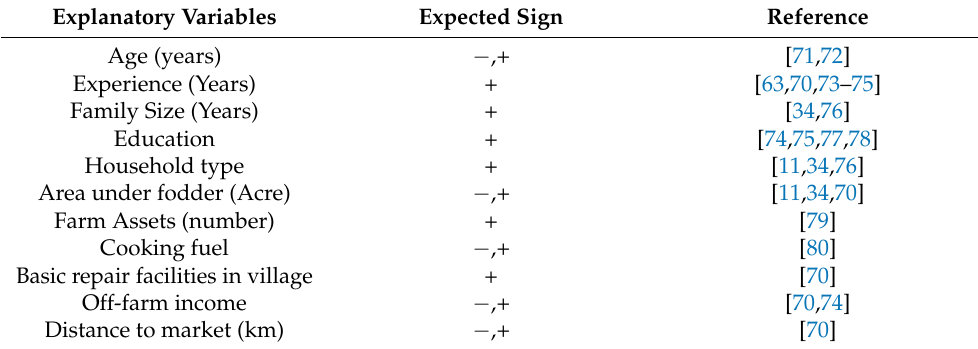
Table 1. Description of model